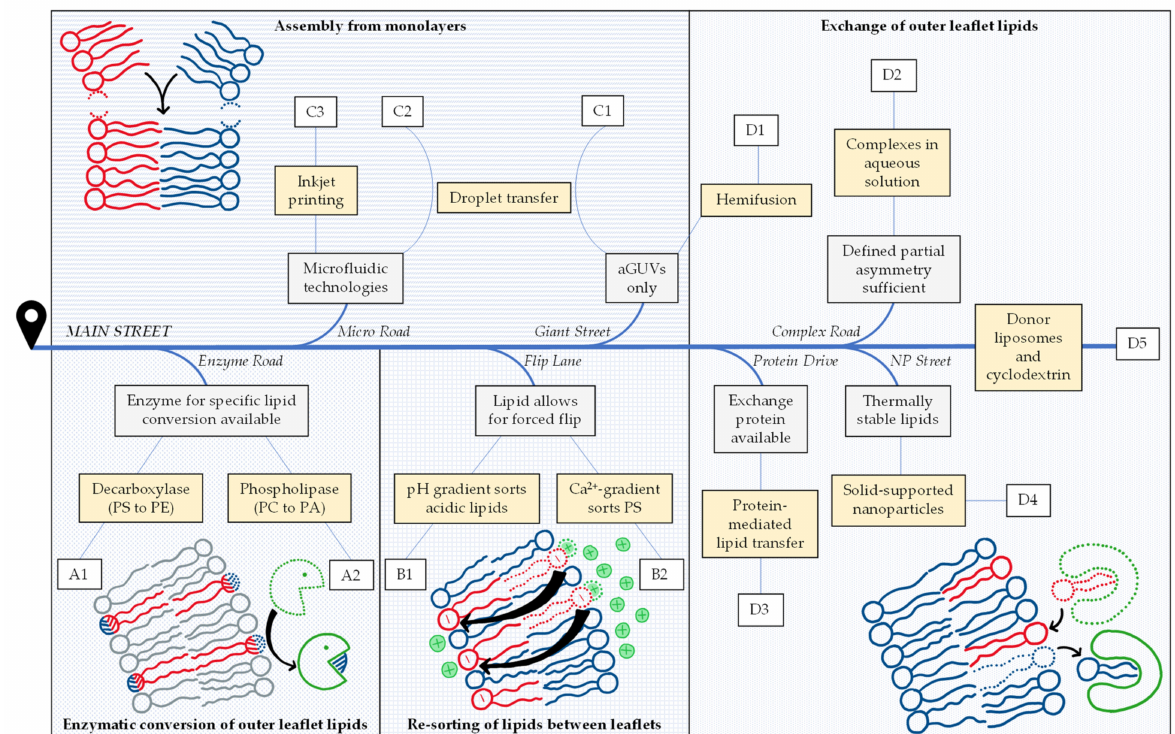
Figure 1. Road map to asymmetry, illustrating the criteria and considerations to select one or more suitable protocols described in the literature for preparing lipid-asymmetric vesicles that suit a given purpose. Eleven protocols are distinguished (yellow boxes) that can be grouped into four strategies (A–D). So far, exchange protocols represent the most abundant and most versatile strategy — illustrated here as the destination of Main Street. Gray boxes (see text for more detail) indicate criteria for exits to alternative protocols that may be favorable for a given purpose. Examples for each protocol ( A1 – D5 ) are listed in Table